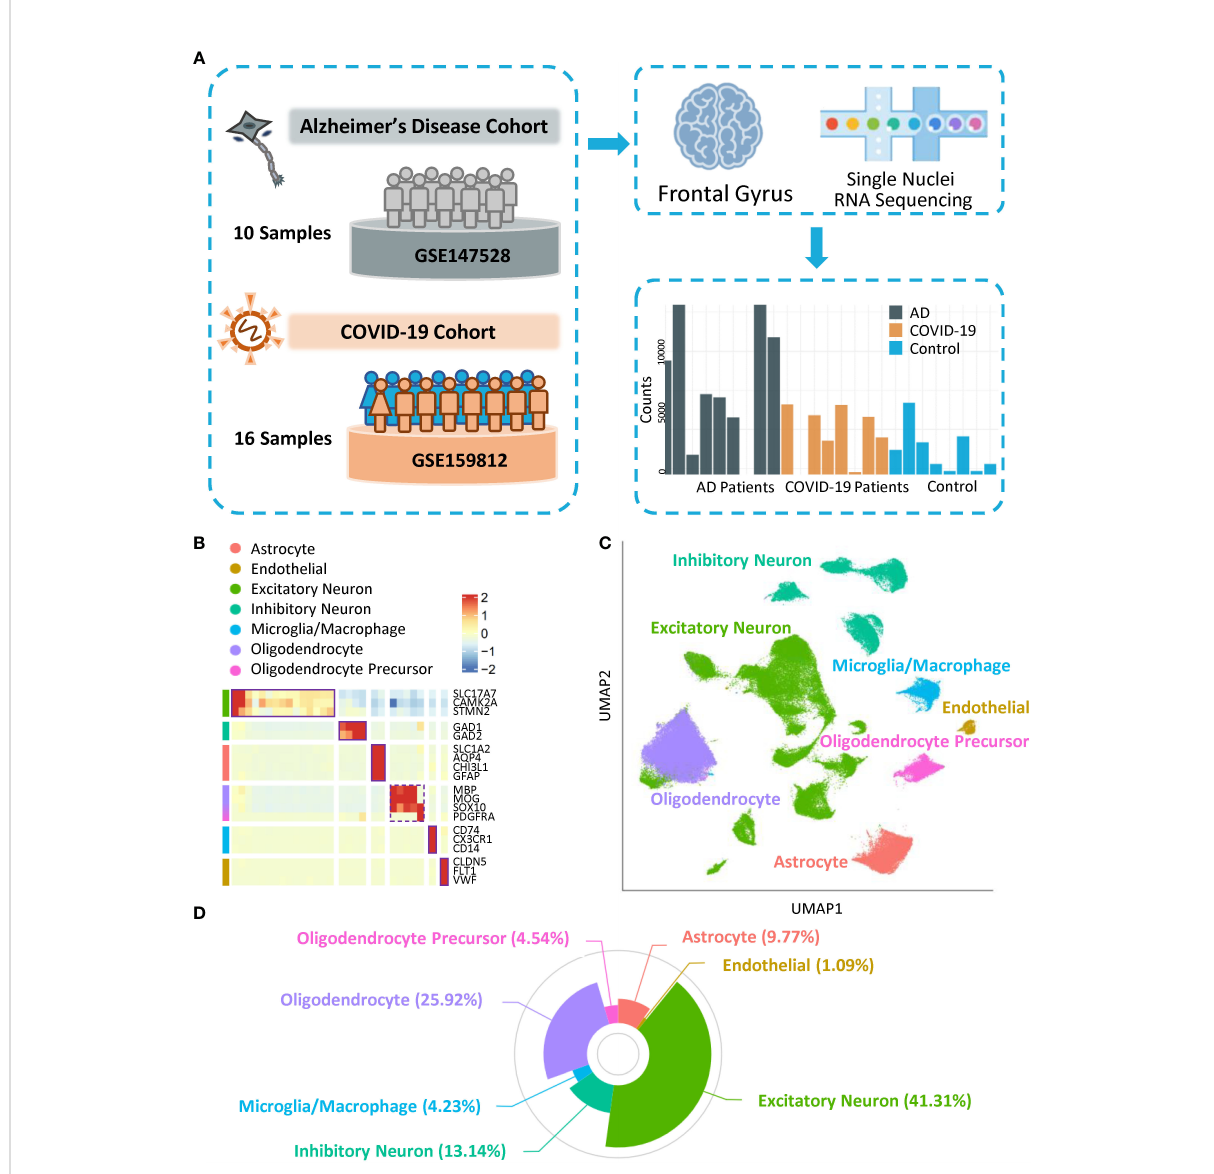
FIGURE 1 Overall landscape of cells. (A) Schematic of datasets from COVID-19 and Alzheimer ’ s Disease Cohorts. (B) Heatmap showing the expression of signature genes in the cells. (C) UMAP visualization of the cell clusters. (D) Composition of each subtype of